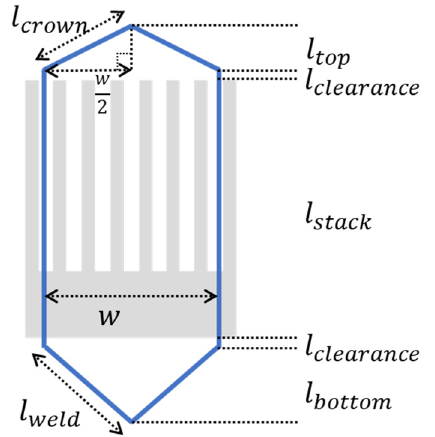
Figure 12. Diamond coil geometry.